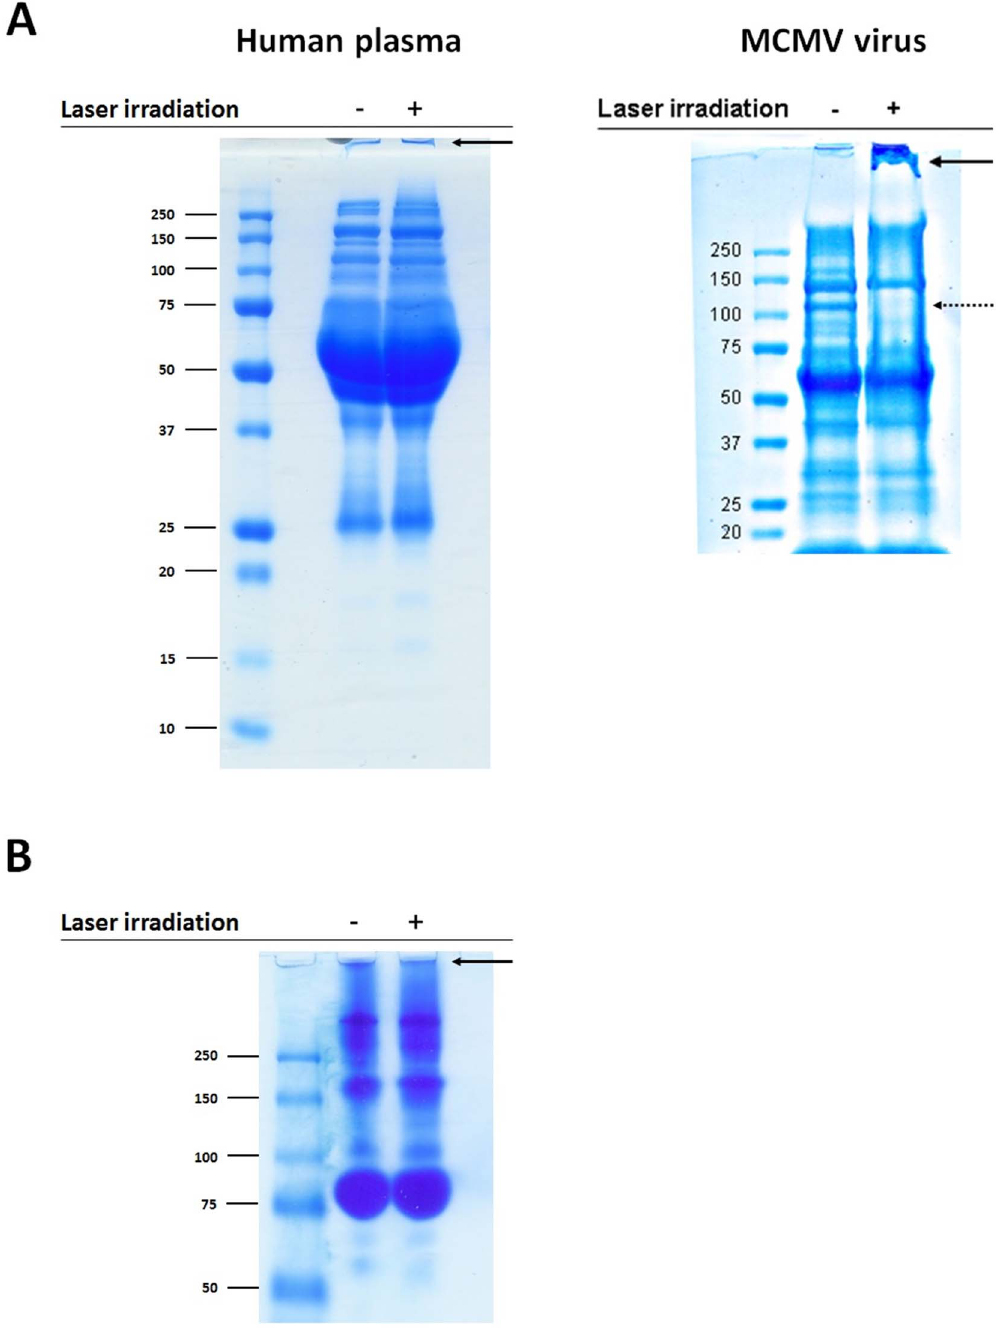
Figure 2. SDS-PAGE and native PAGE analysis of control and USP laser-treated plasma proteins. (A) On the left is shown the SDS-PAGE of control and laser-treated plasma; on the right, for comparison, is shown the SDS-PAGE of laser-treated MCMV virus adapted from Tsen et al [13] (reprinted with permission from the Society of Photo-Optical Instrumentation Engineers). Control (untreated) or USP laser-treated plasma were boiled in reducing buffer and separated on a 10% gel. Proteins were visualized by Coomassie blue stain. The solid arrow indicates the location of low mobility detergent-resistant aggregates; the dotted arrow indicates missing band(s) corresponding to aggregated proteins. (B) Native PAGE of control and laser-treated plasma. Control (untreated) or USP laser-treated plasma were separated on a 10% gel. Proteins were visualized by Coomassie blue stain. Arrows indicate location of low mobility detergent-resistant aggregates. doi:10.1371/journal.pone.0111673.g002 of intensity came from a much larger species, with a hydrody- in both control and laser-treated groups (Table 2). We note that namic radius around 100 nm. Because large aggregates scatter these values represent the percentage of scattered intensity from much more than monomers, these values indicate that roughly monomers (i.e. species with hydrodynamic radius of 12 nm). In 90% of the protein mass was monomeric (assuming that the both the controls and the irradiated samples, the remaining 40%